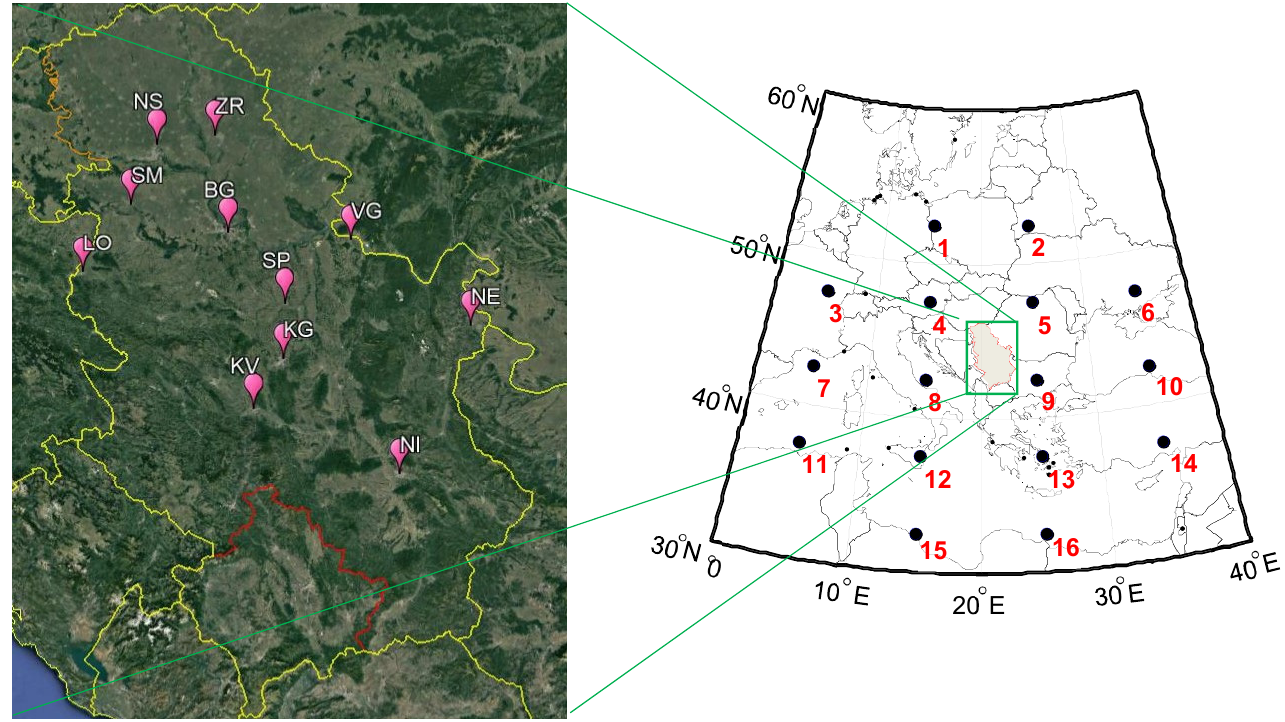
Figure 1. Google Earth view of locations of meteorological stations listed in Table 1 ( left ) and position of Serbia with grid points used to compute circulation weather types ( right ).